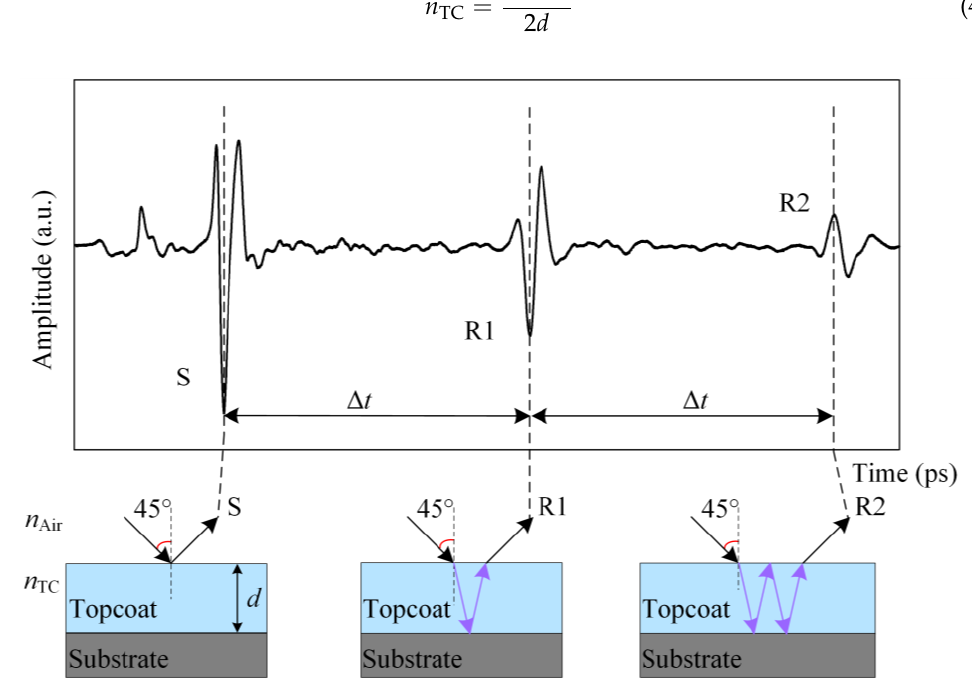
Figure 3. Schematic diagram of the reflective terahertz propagation path inside a specimen.